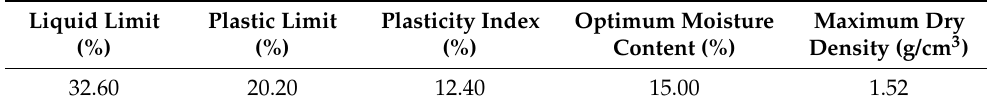
Table 1. Basic physical properties of modified soil [25].